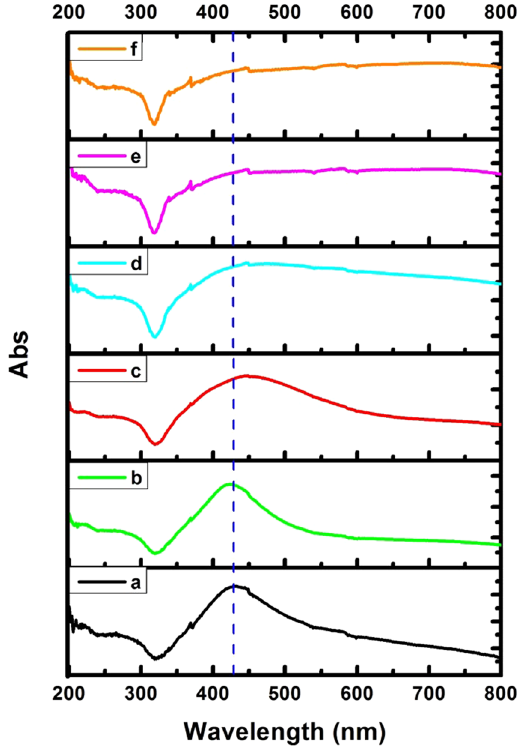
Figure 2. UV-Visible absorption spectra of the synthesized Ag NPs (curve a) and Ag NP@N-GQD (curves b–f) with various mass ratios (Q N-GQD /Q AgNO3 = 0, 0.04, 0.08, 0.12, 0.16 and 0.2,